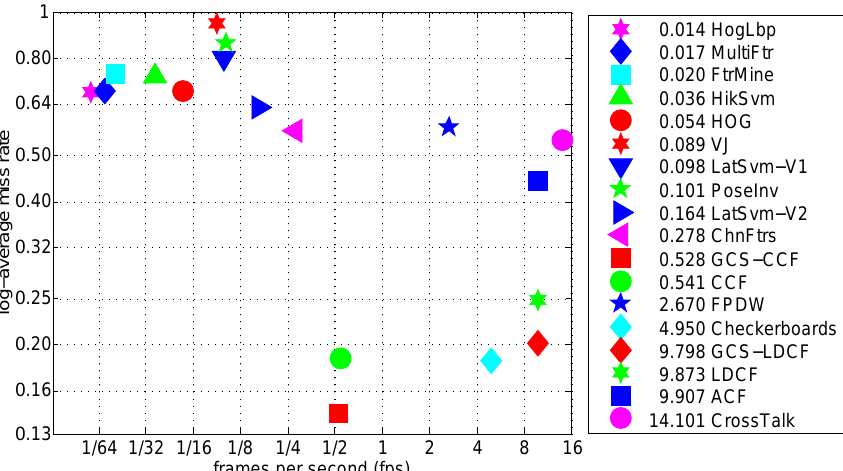
Figure 6. Log-average miss rate vs. runtime of different approaches on Caltech “Reasonable” setting (symbols closer to the bottom-right corner indicating that the corresponding approaches possess both better accuracy and faster runtime